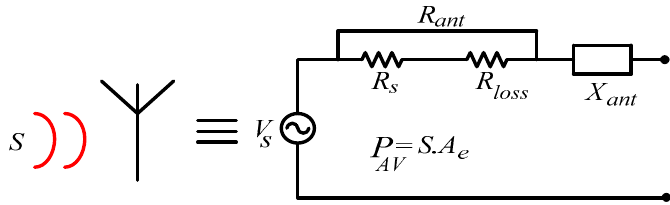
Figure 14. Equivalent electrical model for an antenna [20]. Reprinted from ref. [20].